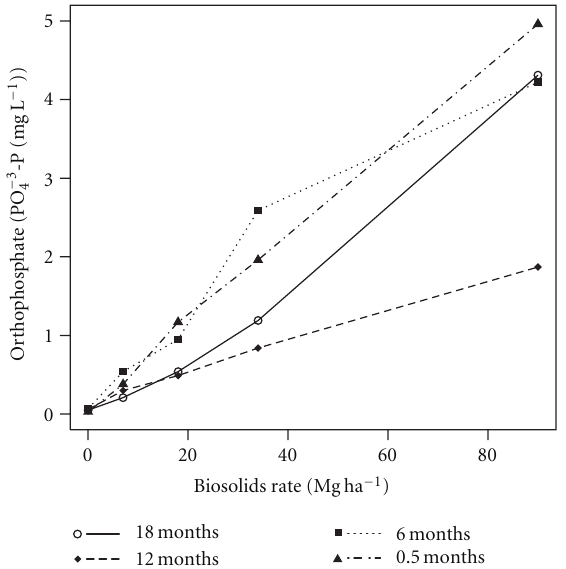
Figure 12: Ammonium, NH 4+ –N, in runo ff water from Stellar soils as a ff ected by postapplication age (18, 12, 6, or 0.5 months) and biosolids application rate (redrawn from [15]).